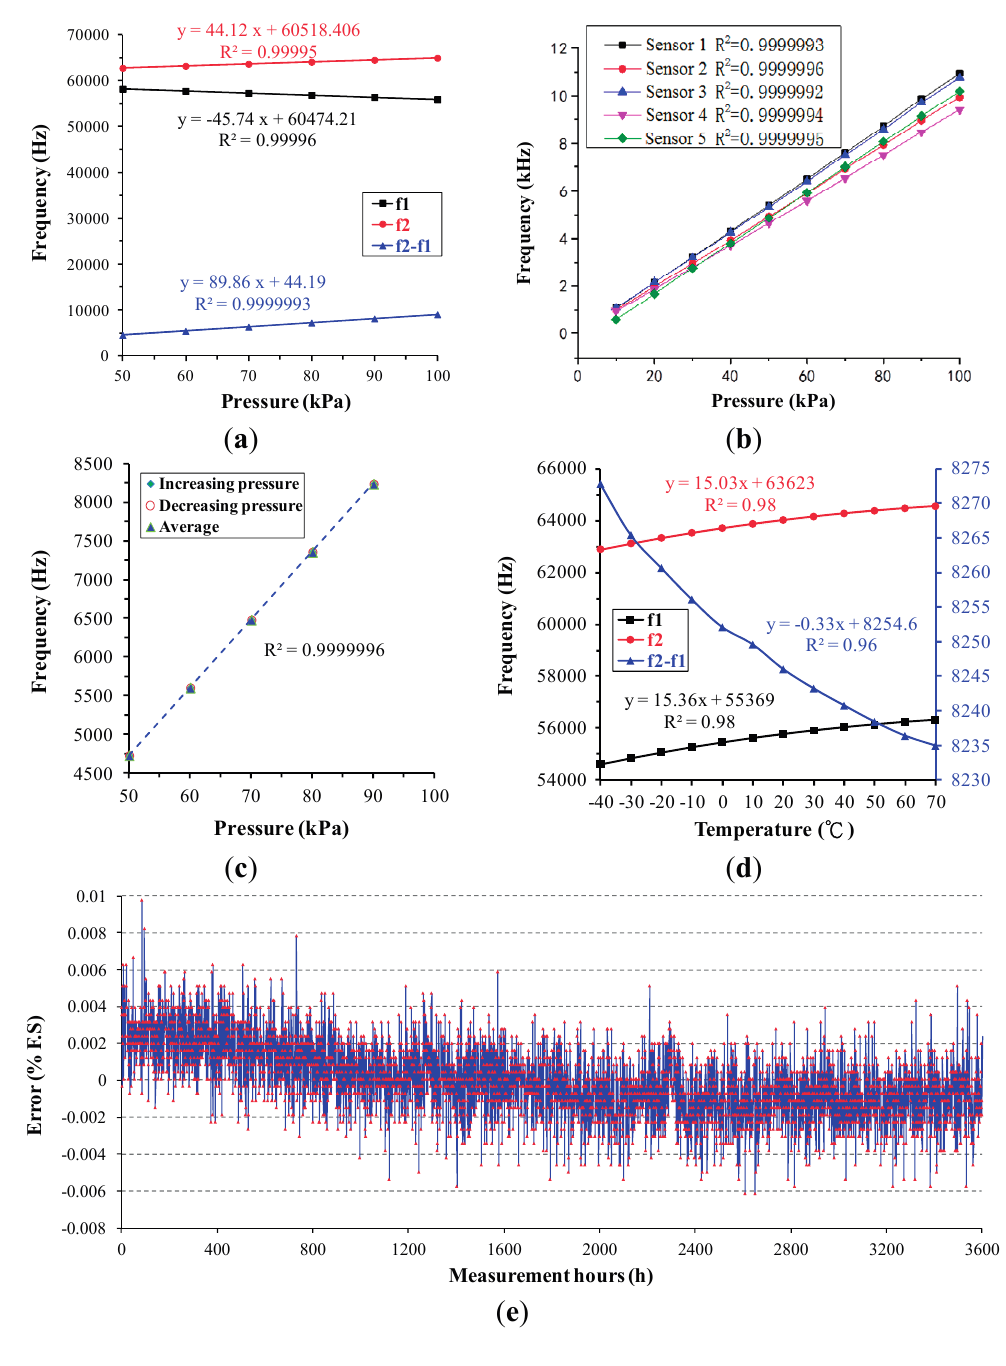
Figure 7. ( a ) The resonant frequencies of the side beam (f1) and the central beam (f2) and the differential frequency output (f2 − f1) of a typical sensor versus applied pressure at 20 ° C. Differential output with nearly balanced sensitivities of two beams improves the nonlinearity and sensitivity of the sensor; ( b ) The plot of the resonant frequency of 5 pressure sensors versus applied pressure, indicating a nonlinearity of 0.02% within the pressure range of 50 kPa to 100 kPa; ( c ) Quantified maximum hysteresis error of 0.03% F.S. and ( d ) resonant frequency shift as a function of the temperature under an applied pressure of 90 kPa in the range of − 40 ° C to 70 ° C; ( e ) Zero-point long-term stability of the developed resonant pressure micro sensor, reporting a long-term stability error of 0.01% F.S over a 5-month